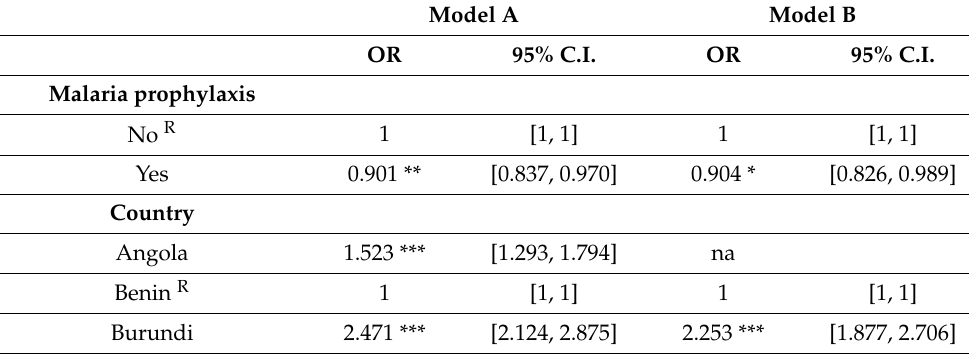
Table 6. Multivariate logistic regression model on